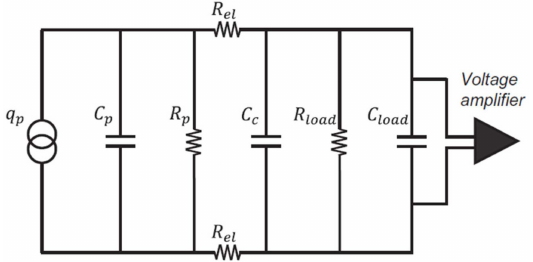
Figure 8. Equivalent electric circuit of the piezoelectric sensor connected to a voltage amplifier.